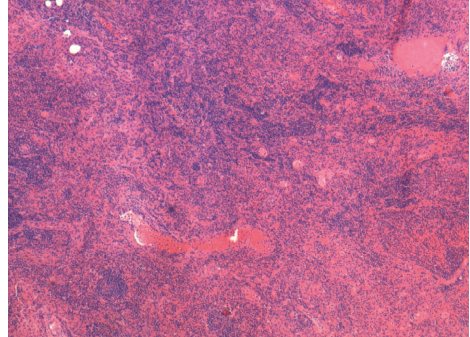
Figure 9: Photomicrograph showing reactive lymph nodes (H&E 20x view).